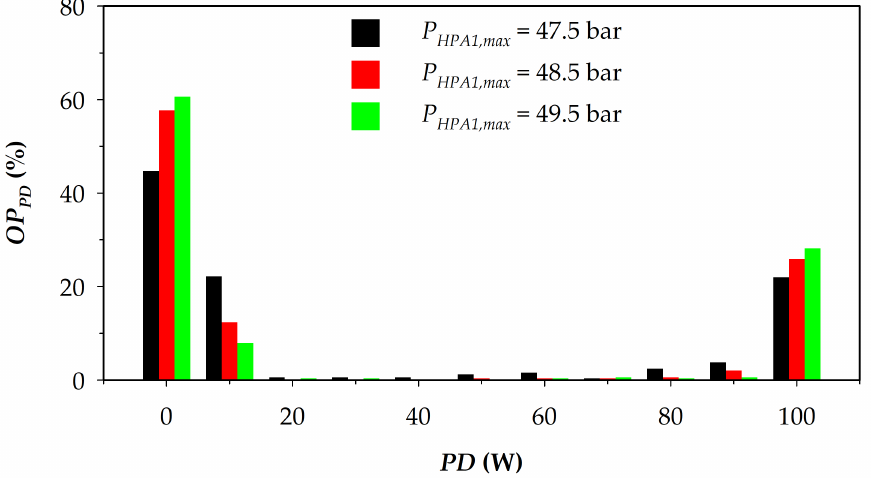
Figure 26. The PD occurrences of the generated electrical power from the improved HPTO unit for different P HPA 1, max cases.